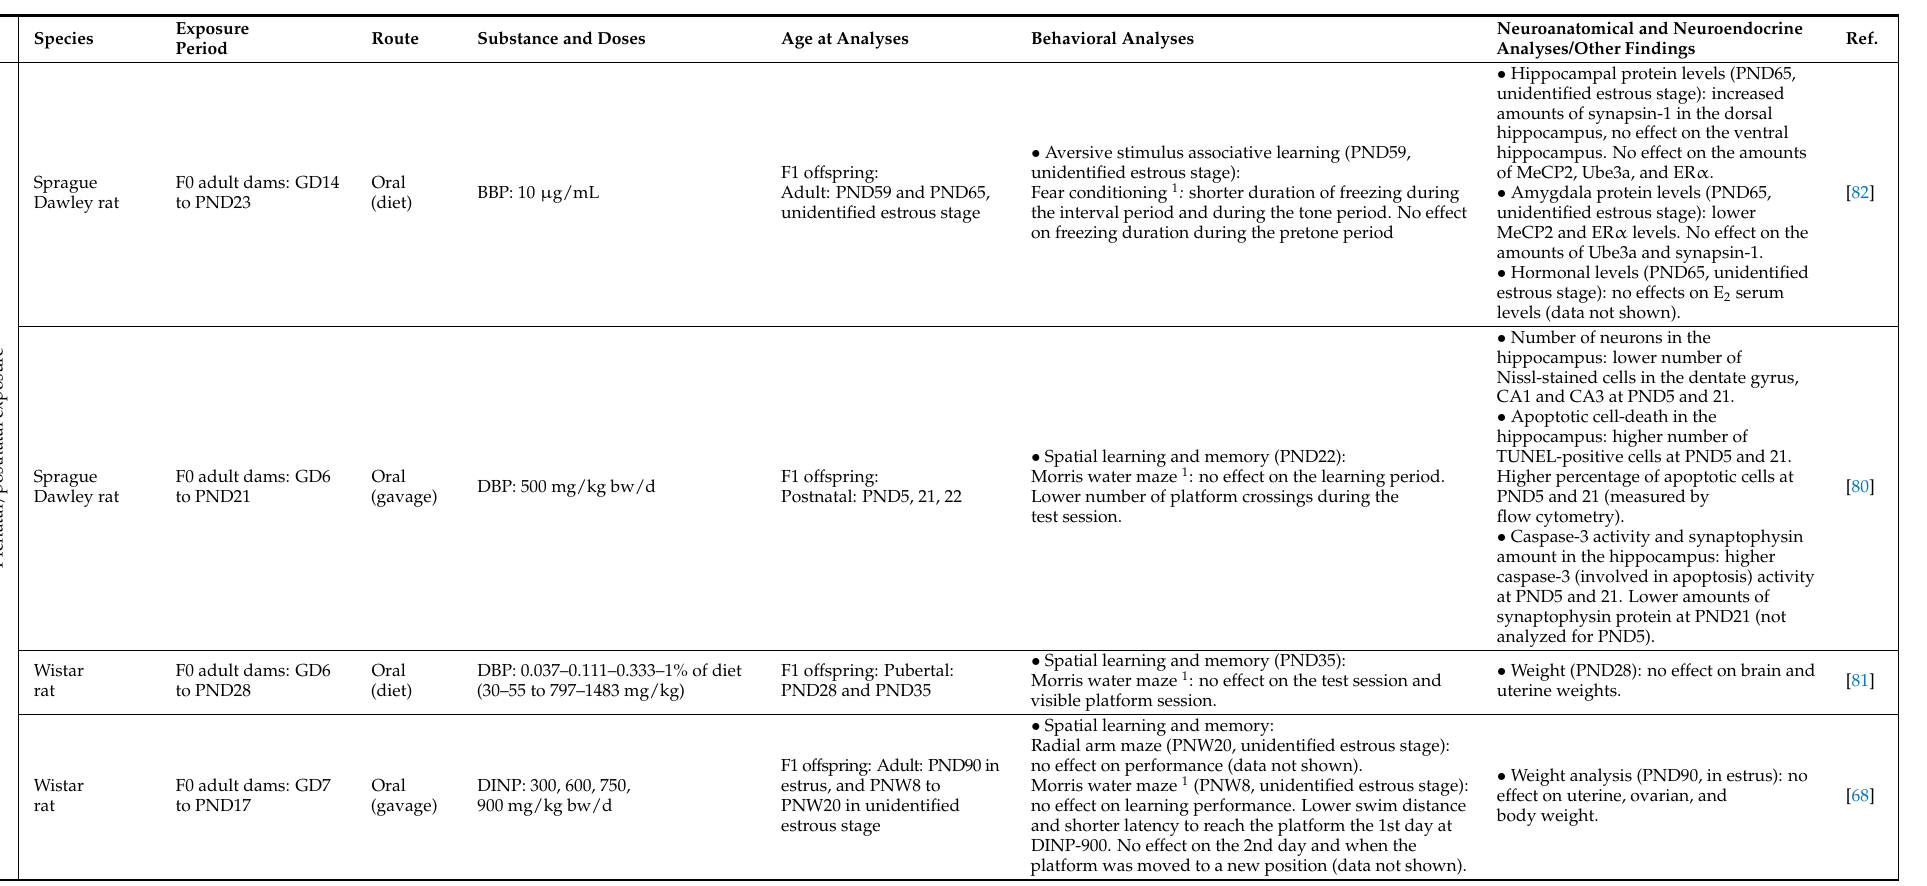
Table 3. Effects of phthalate exposure on learning and memory. BBP, benzyl butyl phthalate; DBP, dibutyl phthalate; DEHP, di-(2-ethylexyl) phthalate; DEP,